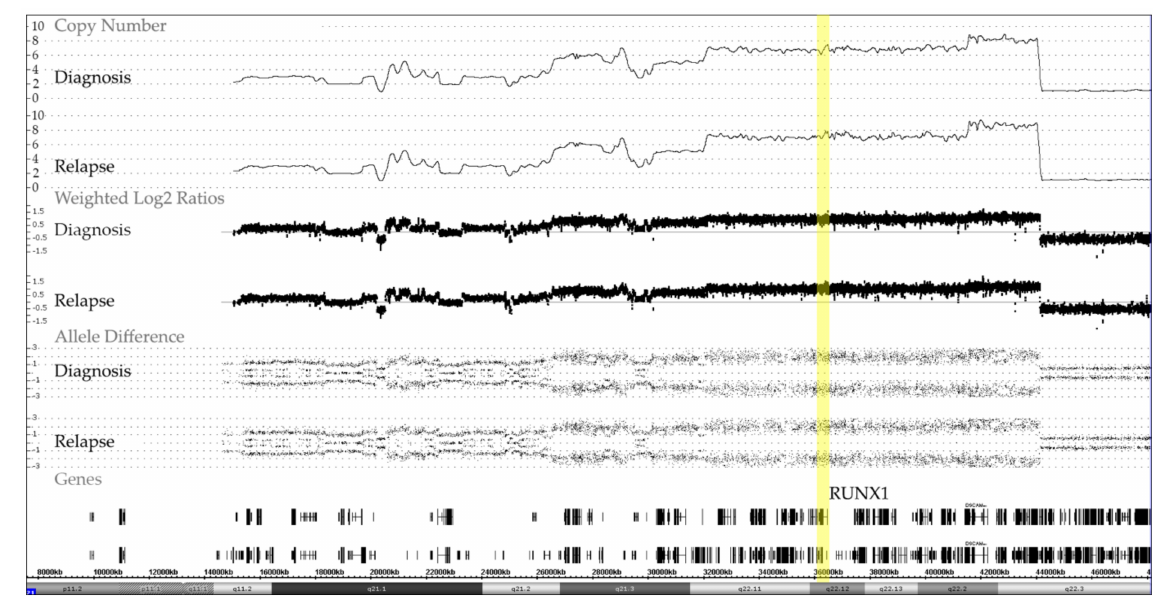
Figure 4. Representative example of chromosome 21 CNA and allele distribution patterns in matched diagnosis and relapse samples of a case with an iAMP21, which also illustrates the remarkable stability of the complex chromosome-wide rearrangement. The common essential feature of all iAMP21 cases is the high-level amplification of the RUNX1 -containing region (yellow bar) that spans about 5.1 Mb and ranges from approximately 32.8 to 37.9 Mb and the virtually always co-occurring deletion of the distal telomeric part